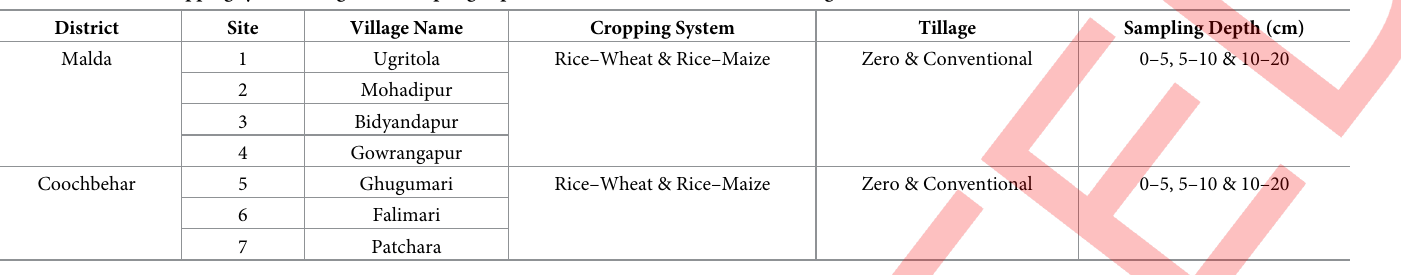
Table 1. Details of cropping system, tillage, and sampling depths in 7 sites of 2 districts of West Bengal, India.